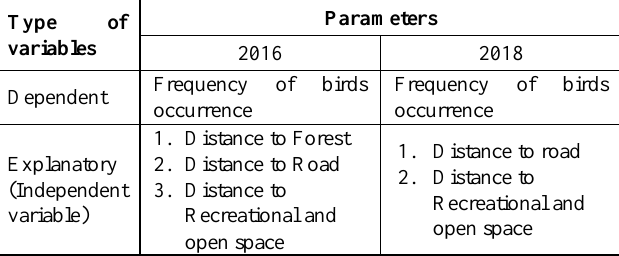
Table 2 A List of dependent and independent variables used